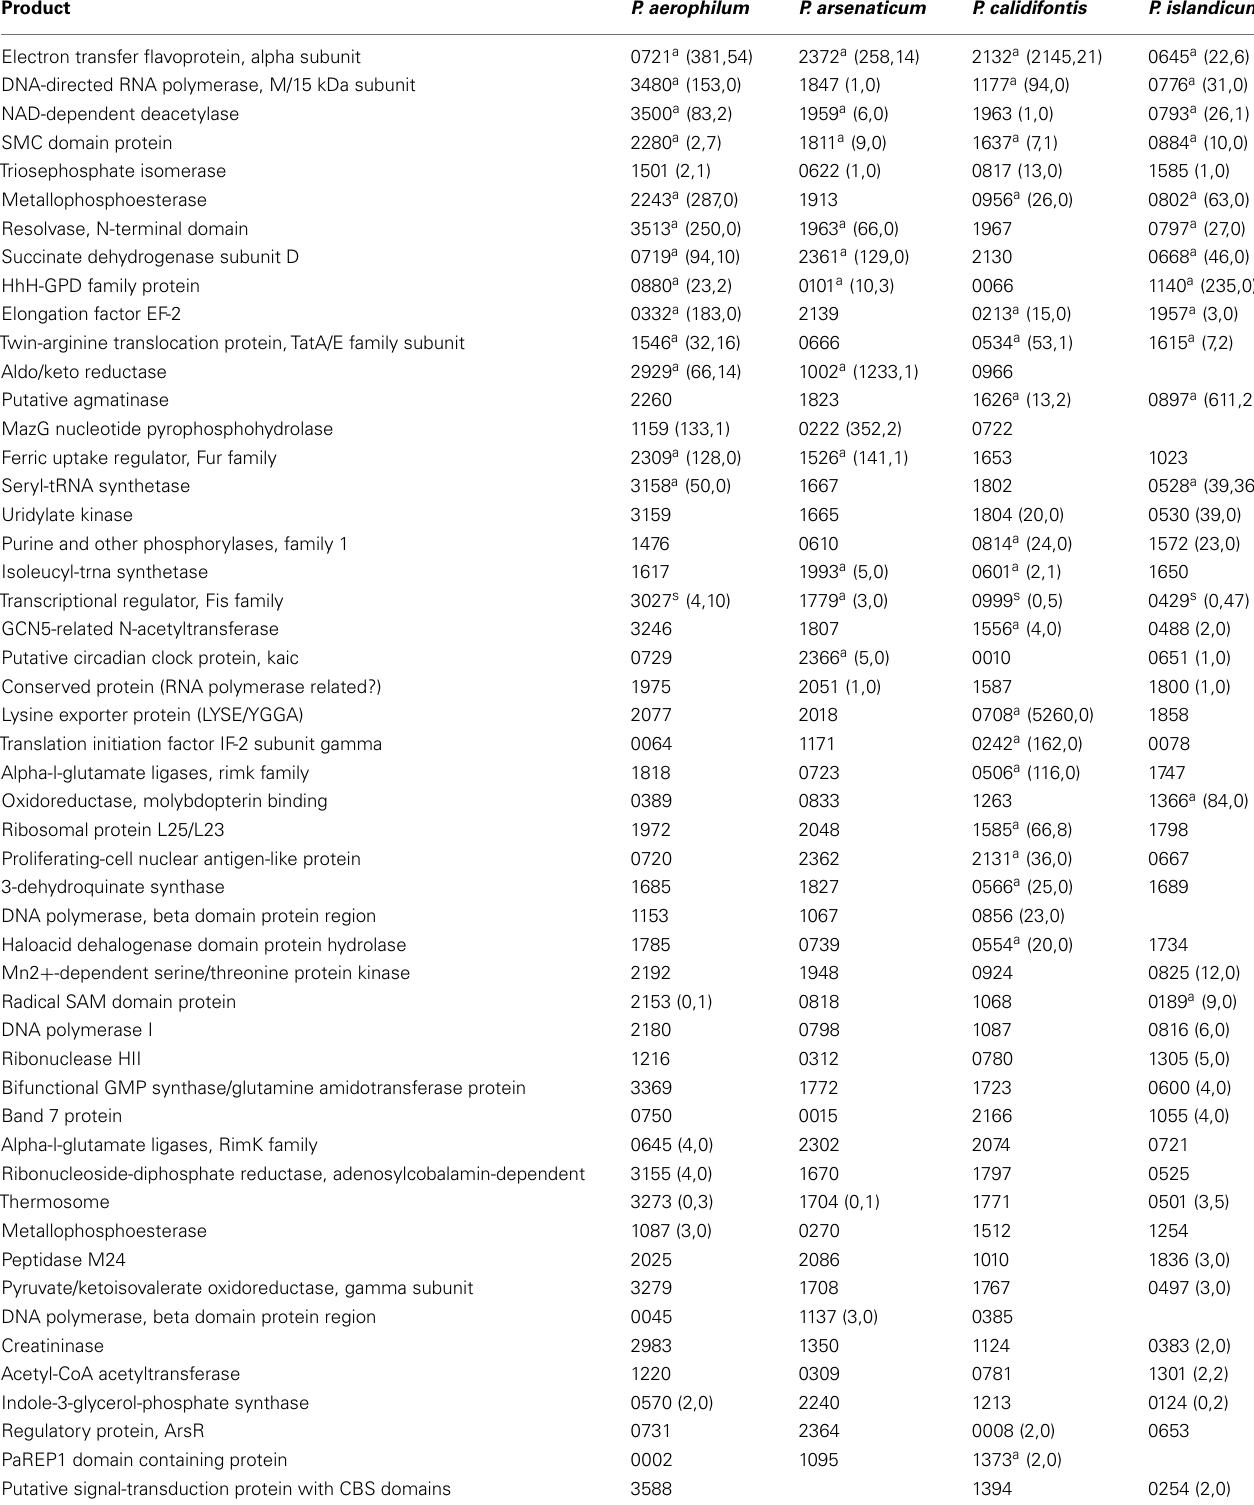
TableA2 | Orthologous genes with 3’ sequencing reads. Orthologous groups, read counts, and footnotes displayed are as described in TableA1